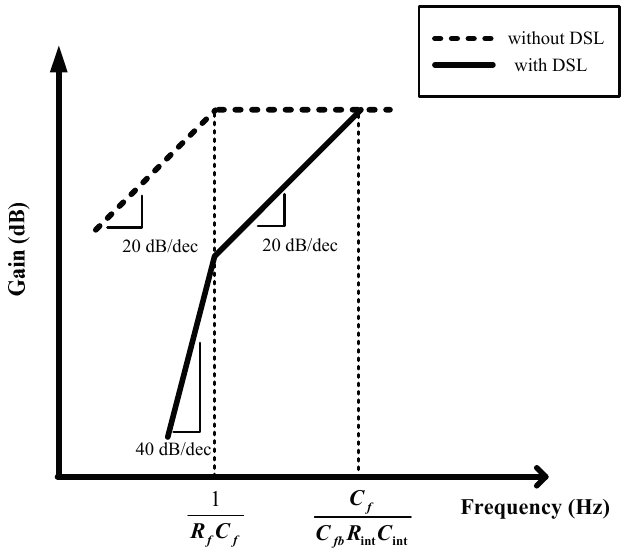
Figure 9. Frequency response of the CCIA.